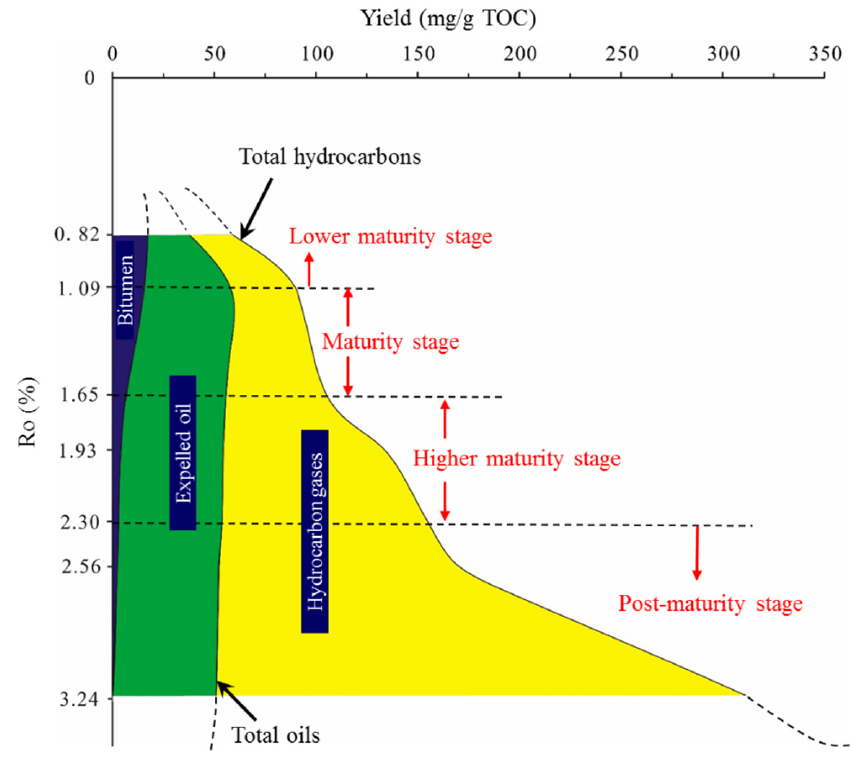
Figure 7. The yield of expelled oil, residual bitumen, and gaseous hydrocarbons with the increasing maturity. Table 2. The slope to the curve of increased hydrocarbons yield ( kn ).